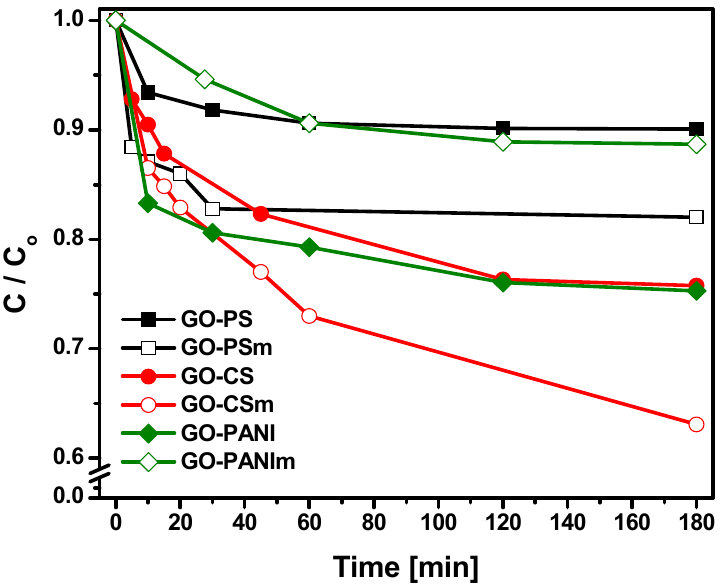
Figure 9. Influence of contact time on the adsorption of BPA.